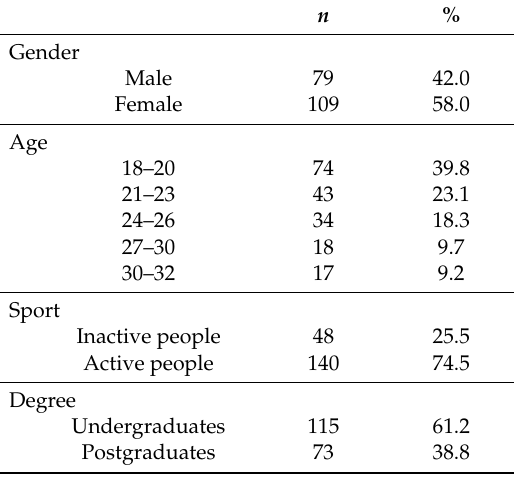
Table 3. Sample characteristics ( n =